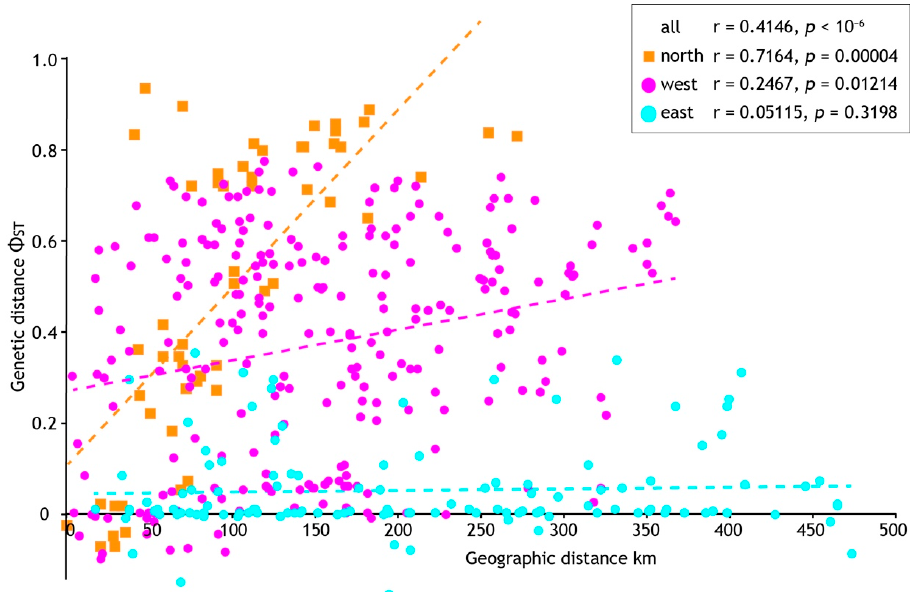
Figure 6. The relationship between geographic and genetic distance among population samples of Acanthophlebia cruentata . Results of Mantel test for all samples and geographic subsets (see Figure 4).